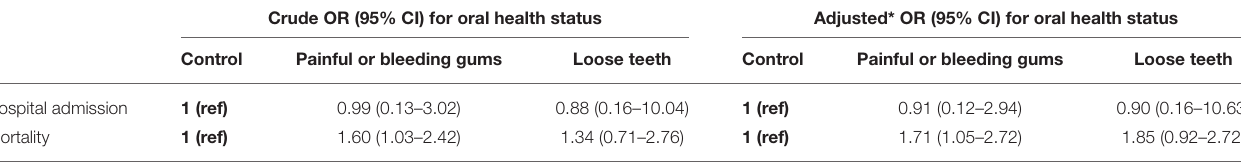
TABLE 3 | Association between oral health indicators and hospital admission and mortality for participants with COVID-19